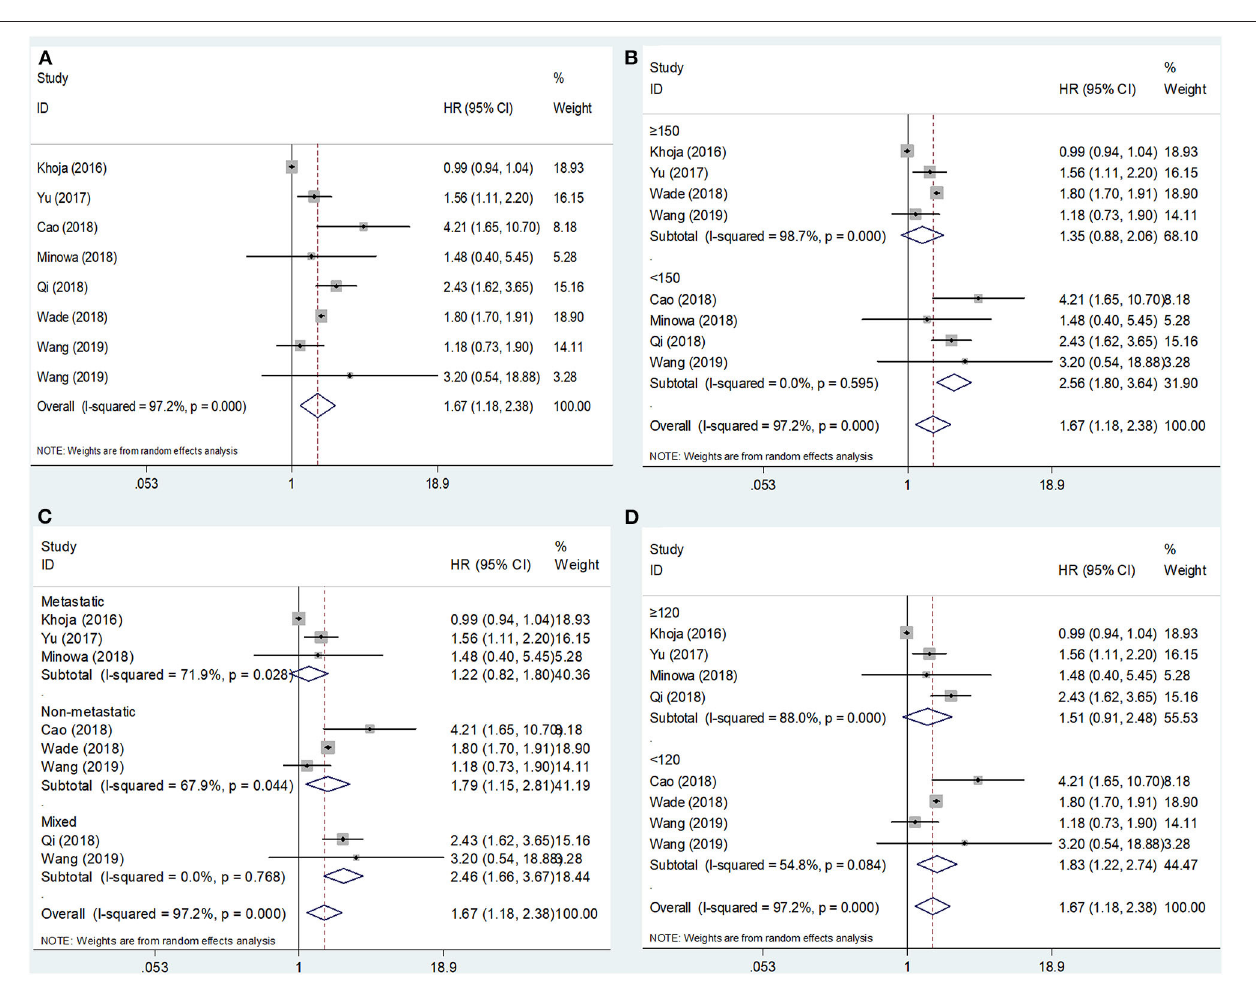
FIGURE 2 | Forest plot hazard ratio (HR) for the correlation between elevated platelet-to-lymphocyte ratio (PLR) and overall survival in melanoma. (A) For the total patients’ group; (B) Subgroup analysis stratified by sample size; (C) Subgroup analysis stratified by disease status; and (D) Subgroup analysis stratified by the cutoff value of PLR. All analyses were performed using a random-effects model.